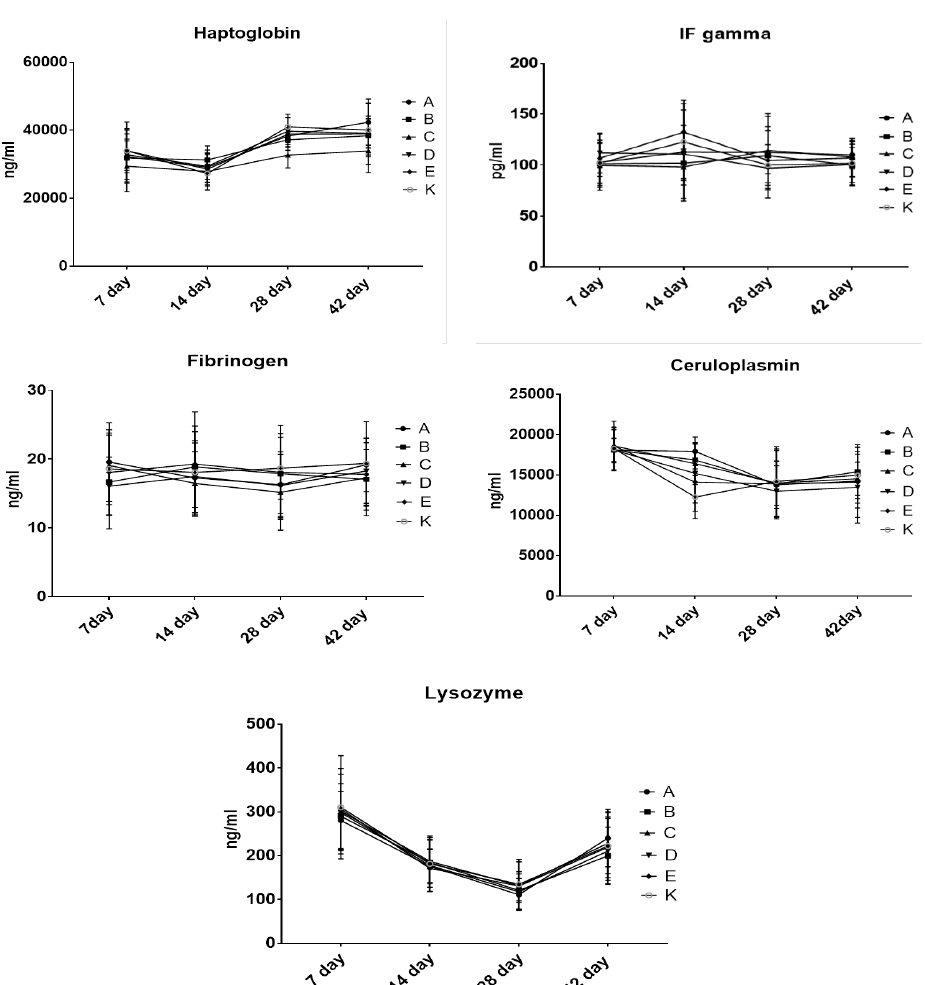
Figure 3. Levels of lysozyme and selected acute phase proteins in the chicken blood.